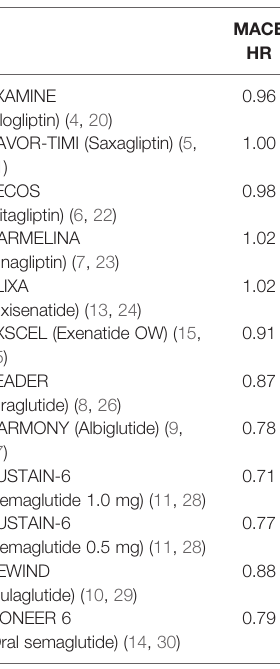
TABLE 2 | Exposure – response related